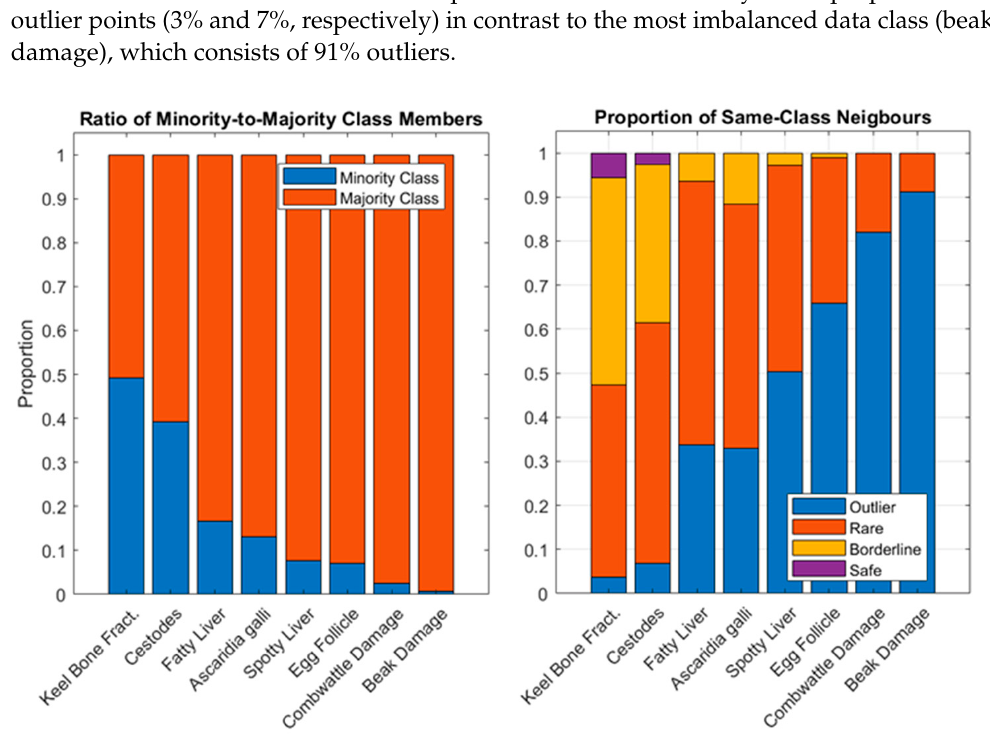
Figure 3. ( Left ) the ratio of minority-to-majority class samples for each target. ( Right ) the proportion of data points in the minority class that fall into the outlier, rare, borderline, and safe neighbor categories.